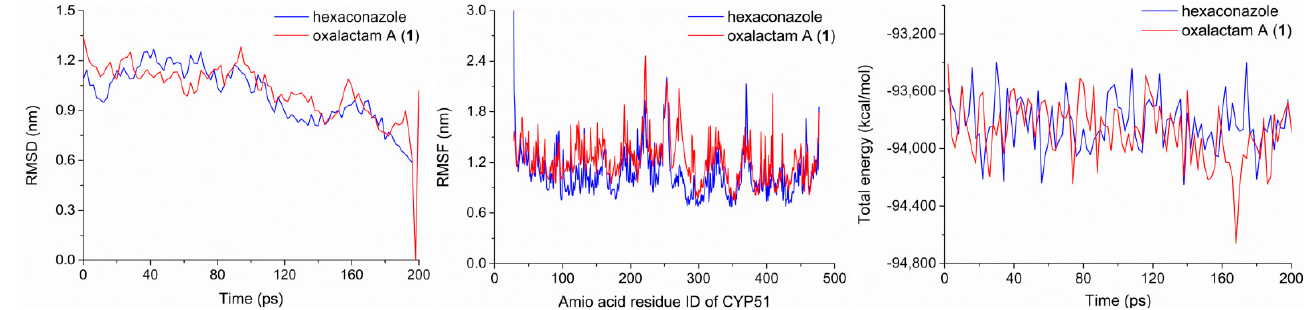
Figure 8. Molecular dynamics trajectory analysis of CYP51 − 1 and CYP51 − hexaconazole complexes, including the RMSD, RMSF, and the total energy.